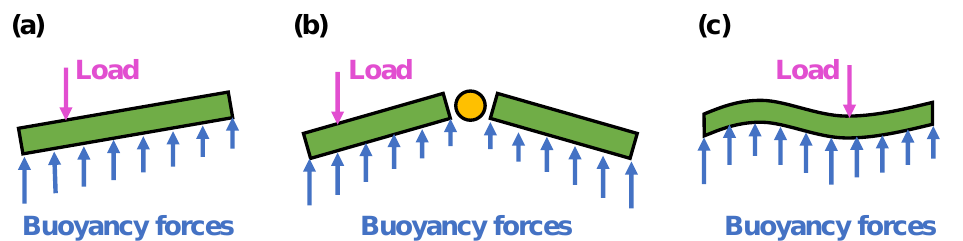
Figure 18. Typical structure responses of ocean engineering structures with rigid body ( a ), connected body ( b ), and flexible body ( c ) (adapted from [6]). Panels ( b , c ) represent the flexible deformations caused by the connectors and the structures themselves,